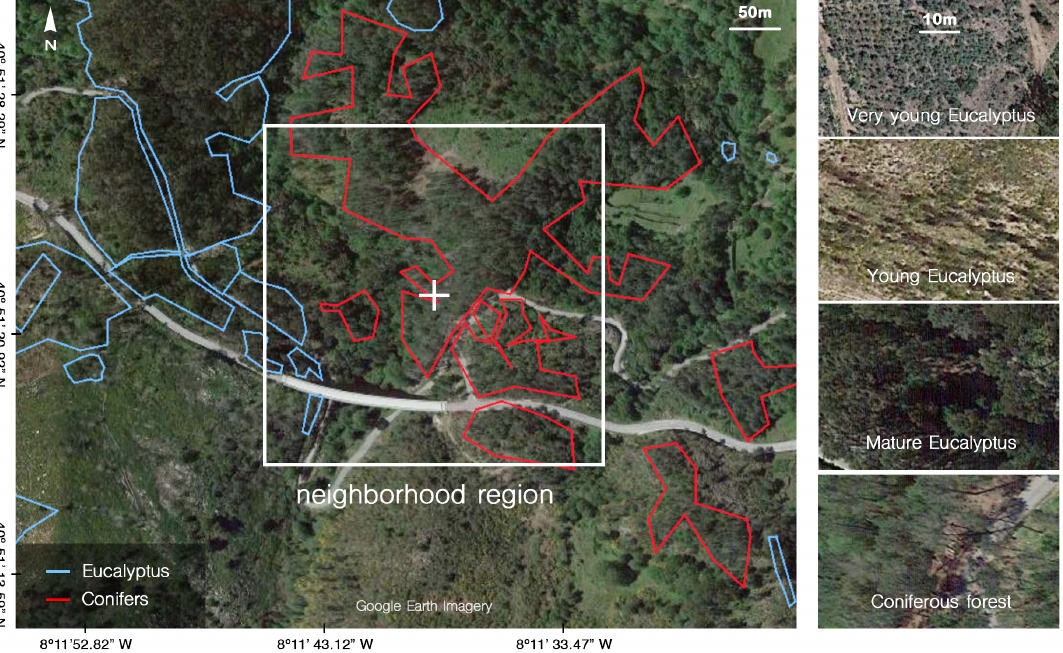
Figure 2. In the left pane shows parts of the compiled ground truth map consisting of polygons that were drawn manually for Eucalyptus and Coniferous forests. Samples of high resolution Google Earth imagery used to create this map are shown on the right. The 320 m × 320 m neighborhood region that is considered by the model as an input is visualized as an